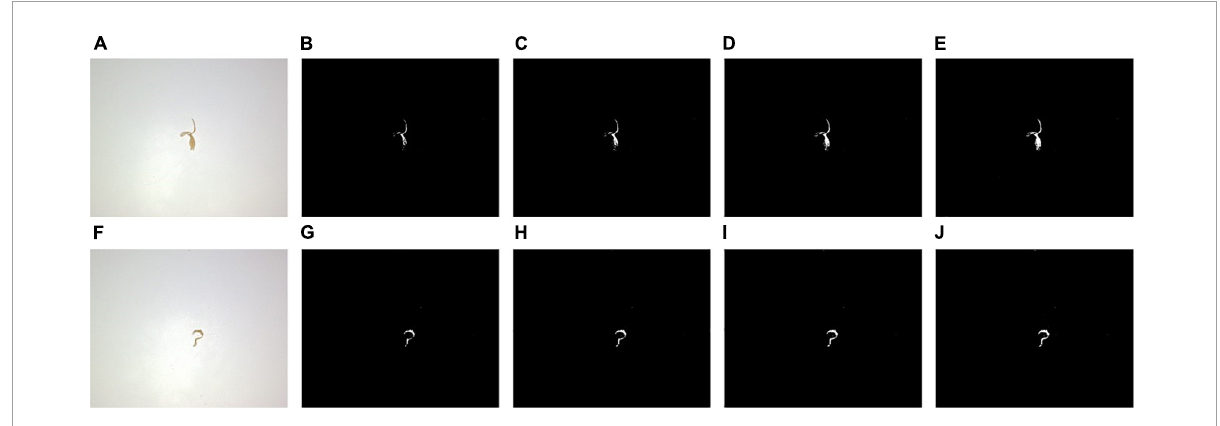
FIGURE4 Results of simple threshold binarization under different thresholds (A) original image 1, (B) threshold 165, (C) threshold 170, (D) threshold 175, (E) threshold 180, (F) original image 2, (G) threshold 165, (H) threshold 170, (I) threshold 175, and (J) threshold